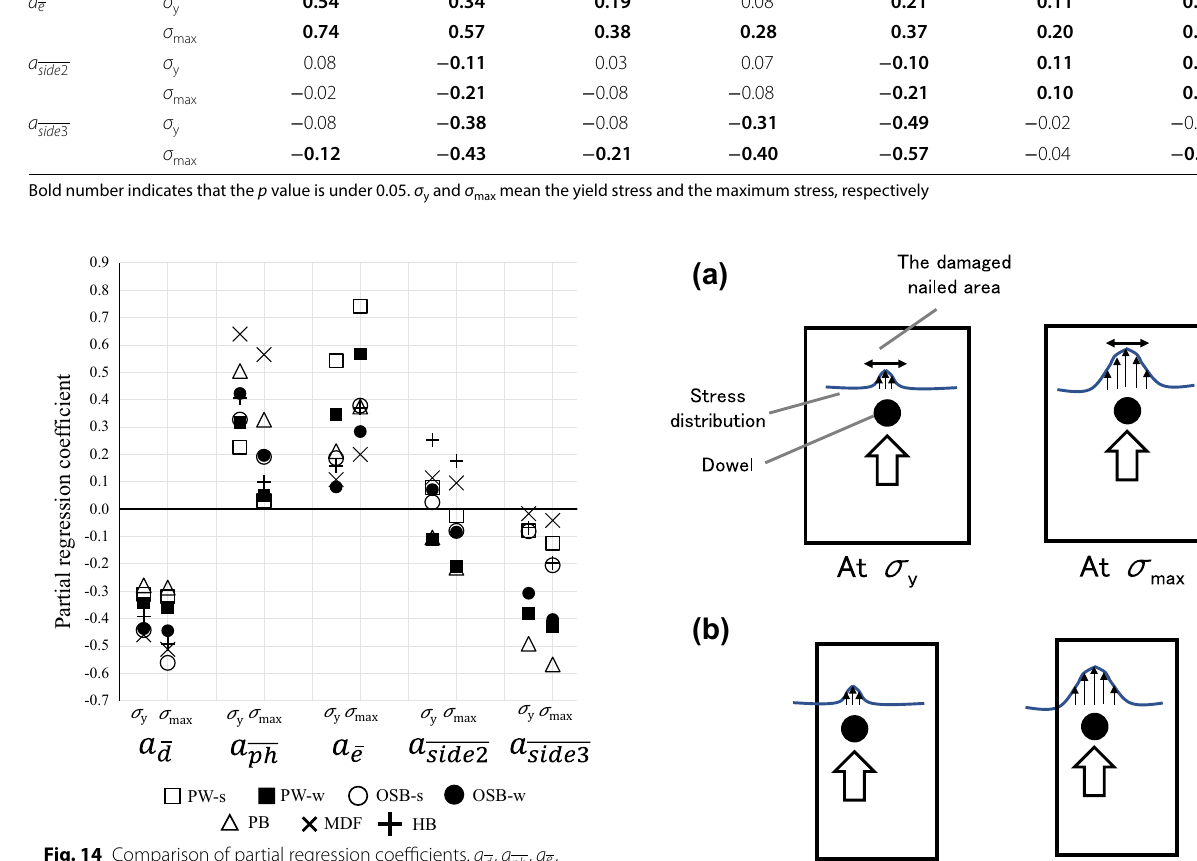
Fig. 14 Comparison of partial regression coefficients. a d , a ph , a e , d , ph , e , side 2 a a side 2 and side 3 mean partial regression coefficients of and side 3 in Eq. 4, respectively Fig. 15 Influence of the widened stress spreading range. a is an illustration demonstrating that ph had a stronger influence on σ y than on σ max . b is an illustration demonstrating that the dowel position had a stronger influence on σ max than on σ